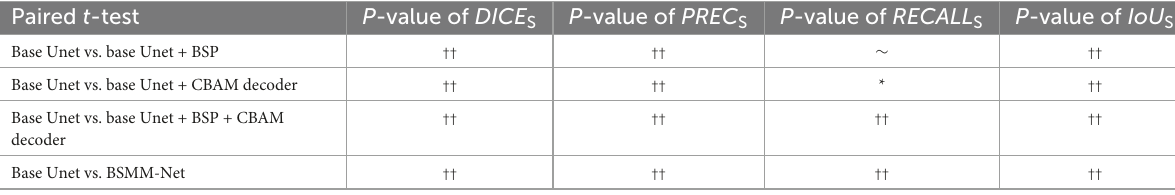
TABLE 5 Hypothesis validation results of the base Unet vs. enhancements. Paired t -test P -value of DICE S P -value of PREC S P -value of RECALL S P -value of IoU